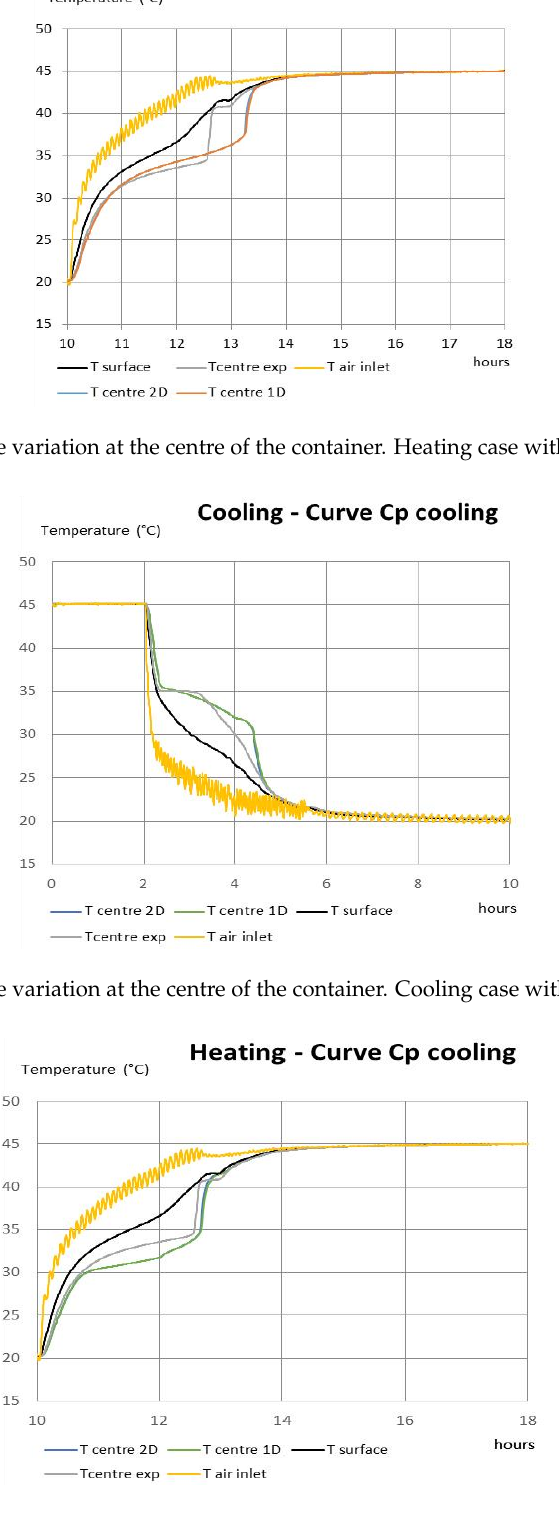
Figure 18. Temperature variation at the centre of the container. Heating case with the cooling c p curve.